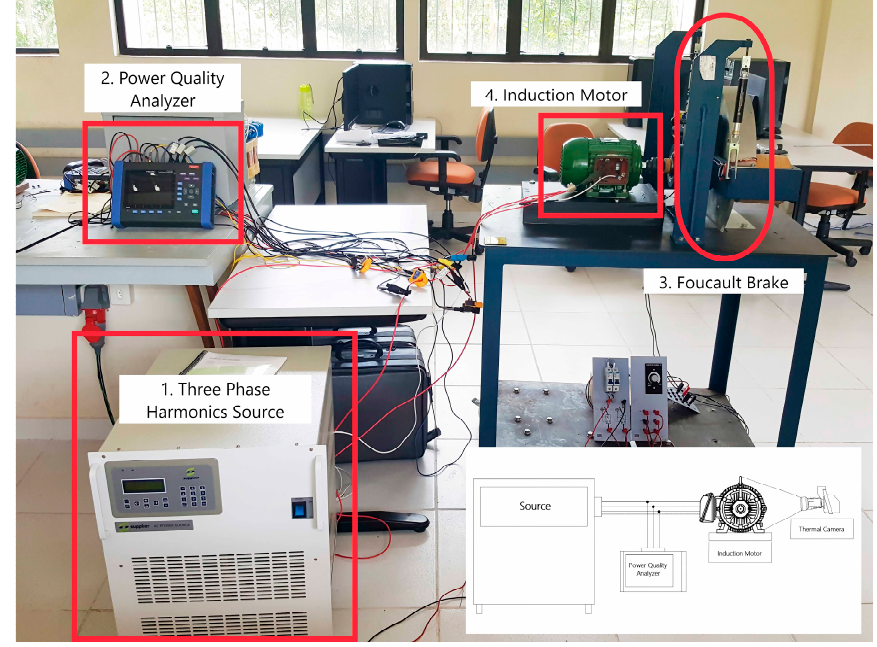
Figure 4. General test setup.